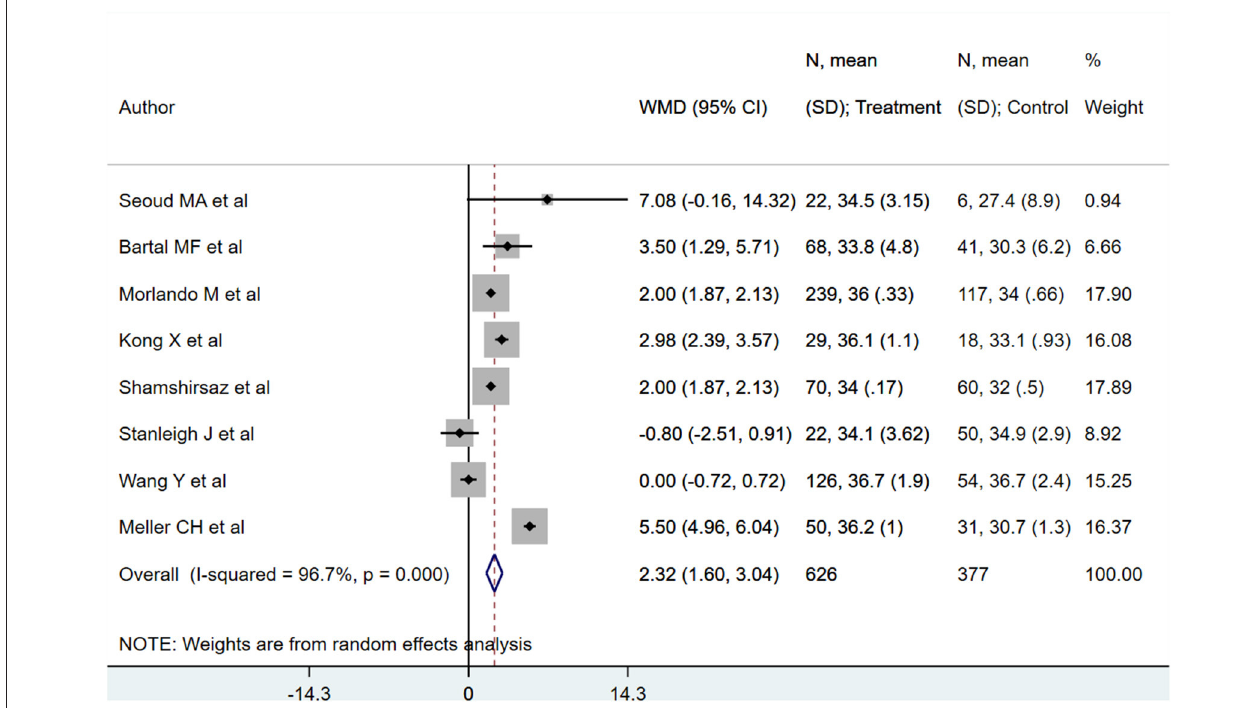
FIGURE 2 | Gestational age for PAS patients undergoing planned or emergency